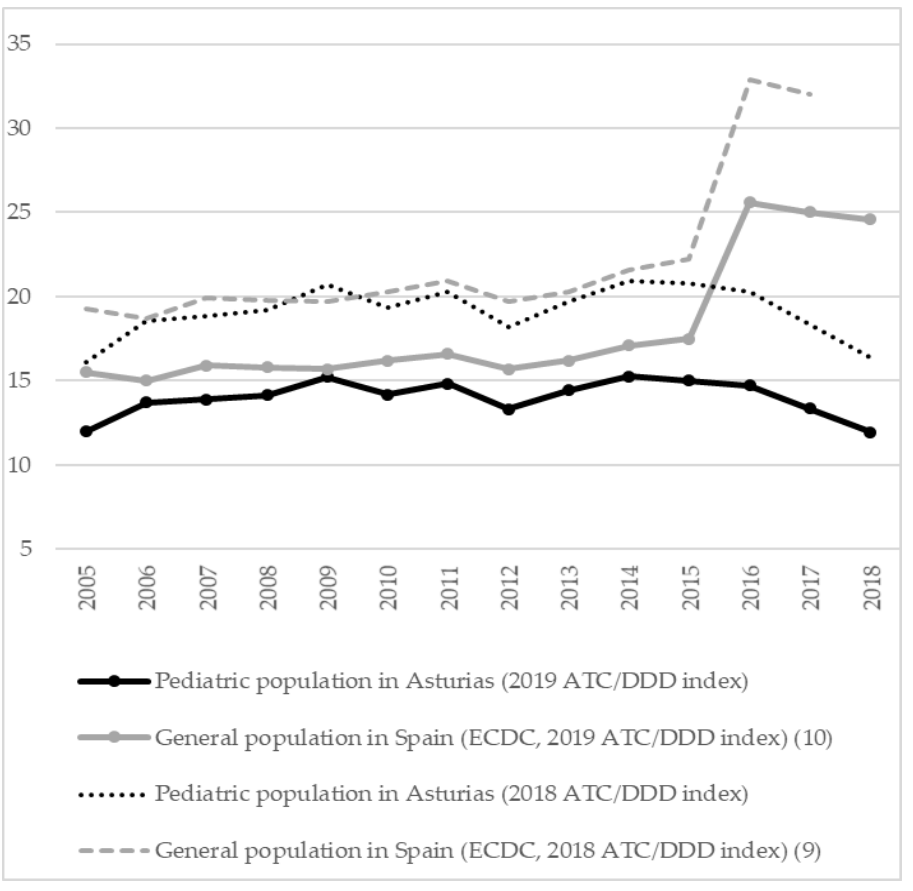
Figure 1. Antibiotic consumption (DID) in the community sector in pediatric outpatients in Asturias and Spanish general population (2005–2018). DID, defined daily dose (DDD) per 1000 inhabitants per day.